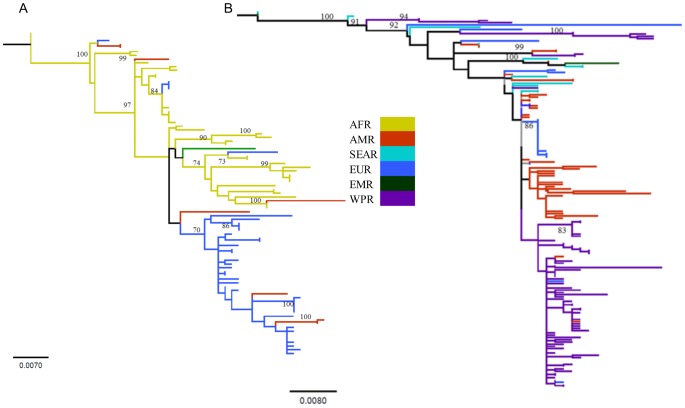
Maximum likelihood trees depicting phylogenetic clustering of the isolates from different regions.(A) Genotype 1G and (B) genotype 2B. Isolates from respective regions are color coded. Although both trees showed multiple genetic clustering, none of the clusters are supported by strong bootstrap support (>70). AFR: African region, AMR: Americas, SEAR: South-East Asia, EUR: European, EMR: Eastern Mediterranean, and WPR: Western Pacific region.